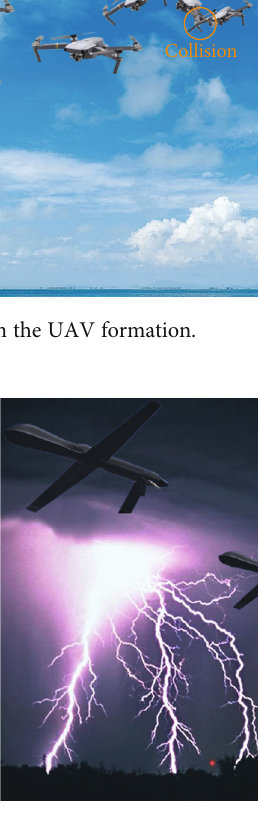
Figure 6: UAV formation fl y in extreme weather.